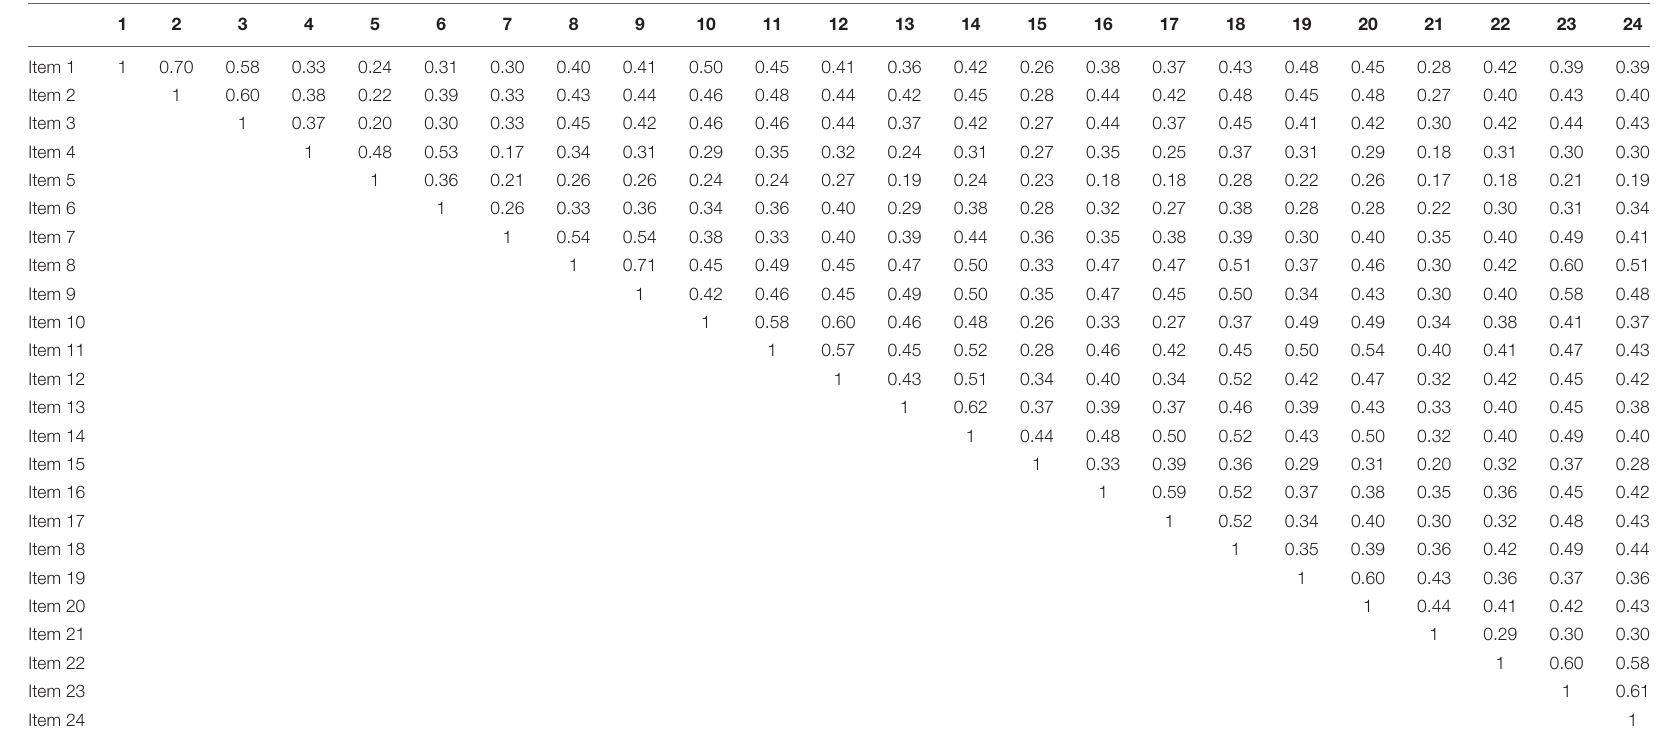
TABLE 2 | Inter-item correlations (Study